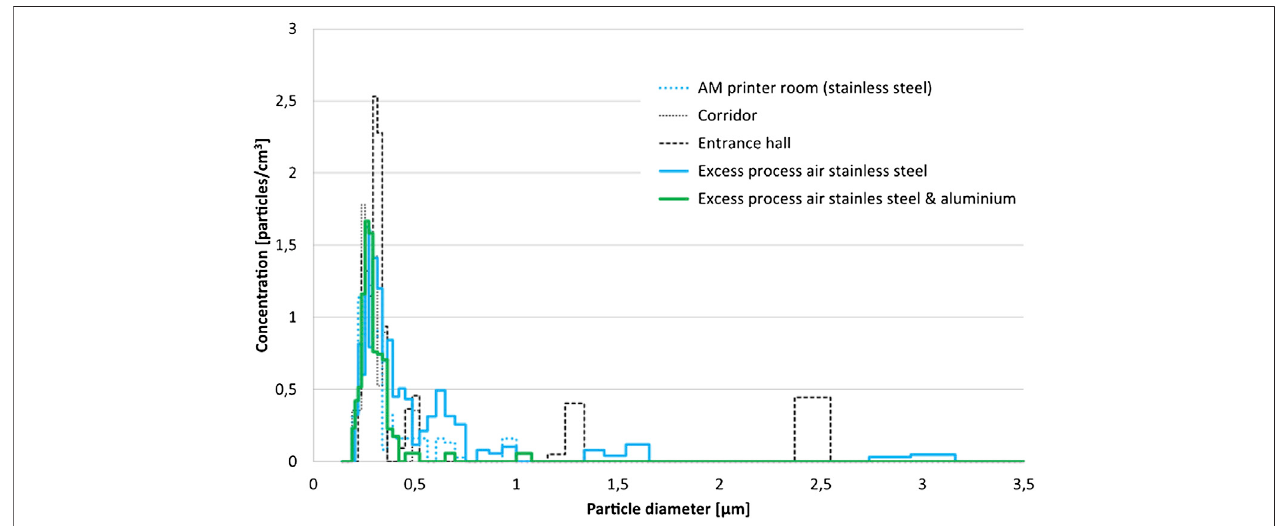
FIGURE 4 | Particles in the AM occupational setting. The particle size distribution was quite similar in all measurement locations. Some larger particles ( > 1 µm) could be found in the entrance hall and in the process air.